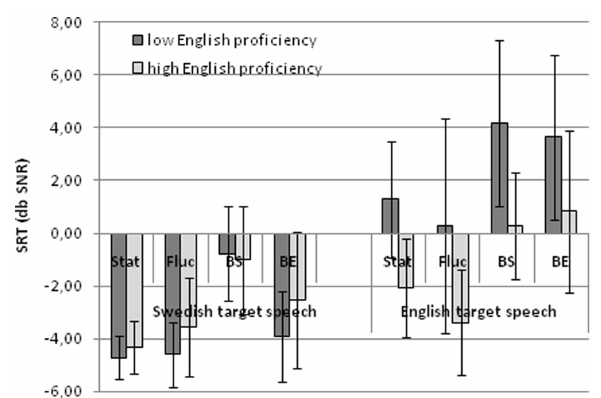
FIGURE 1 |The mean SRTs for the high and low English proficiency group in each of the eight conditions. Error bars reflect standard